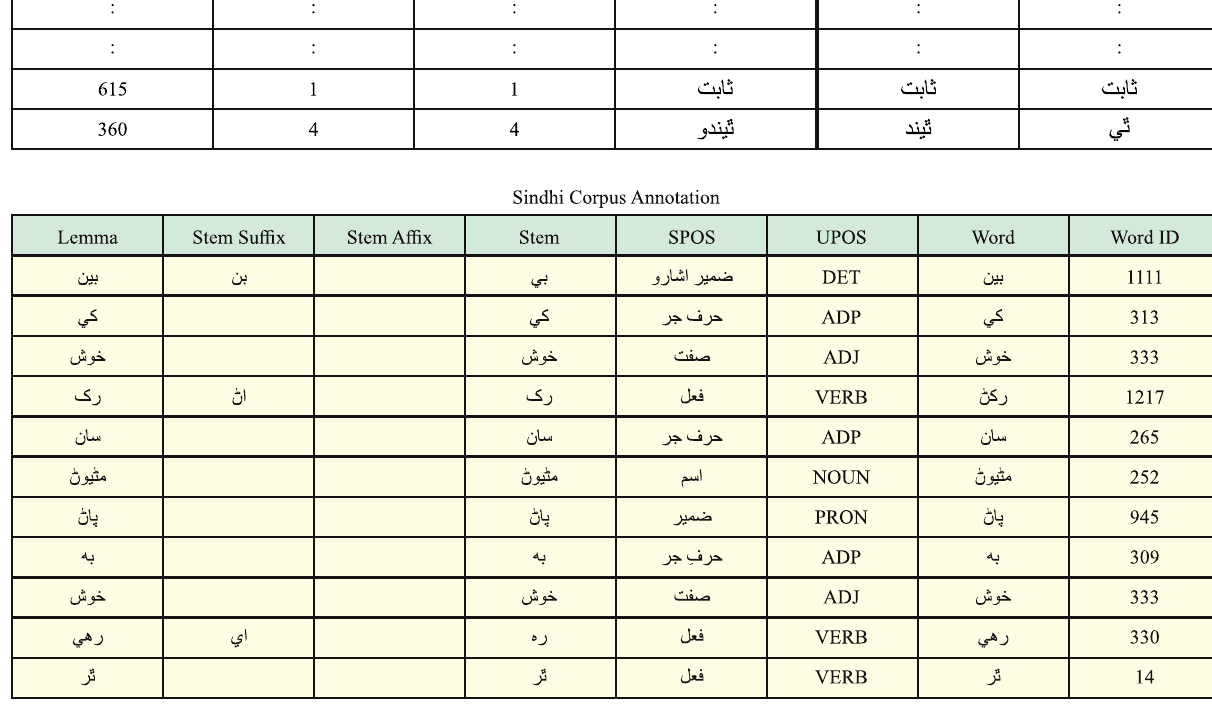
FIG. 4. ANNOTATION OF SINDHI TEXT